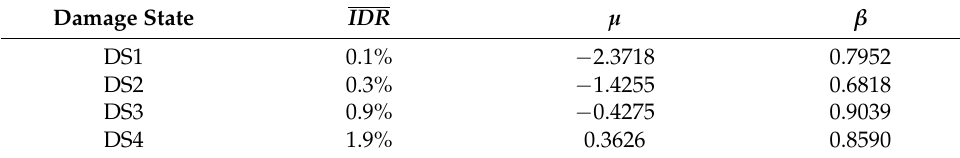
Table 6. Design loads information.